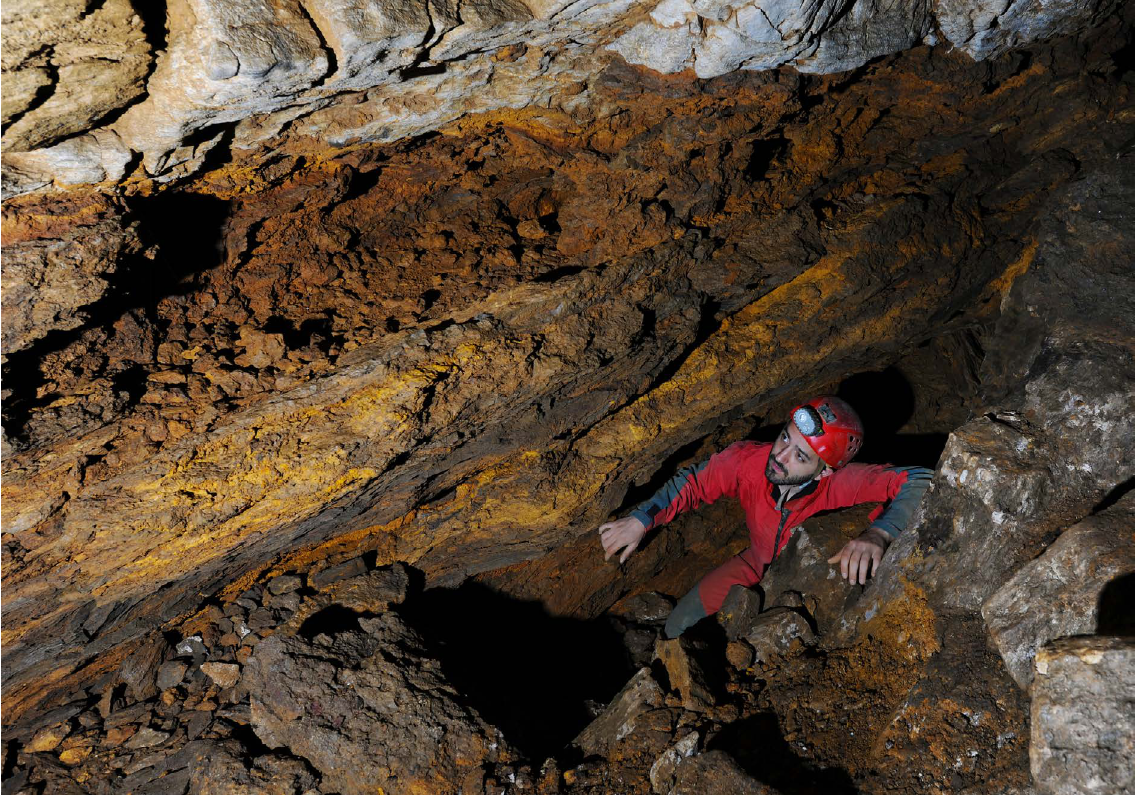
Figure 2. A thick goethite vein on a rocky wall within Grotta della